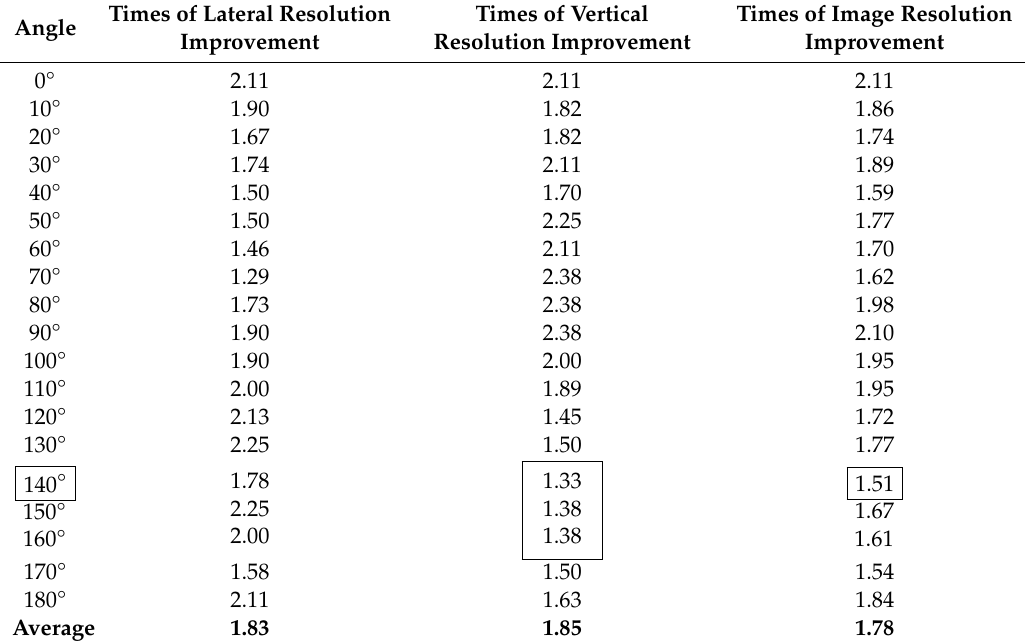
Table 1. Comparison of clockwise rotation resolution improvement